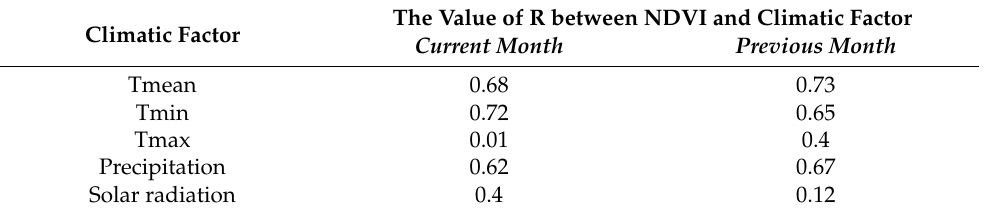
Table 2. The relationship between NDVI and climactic factor in current month and previous month. The Value of R between NDVI and Climatic Climatic Factor